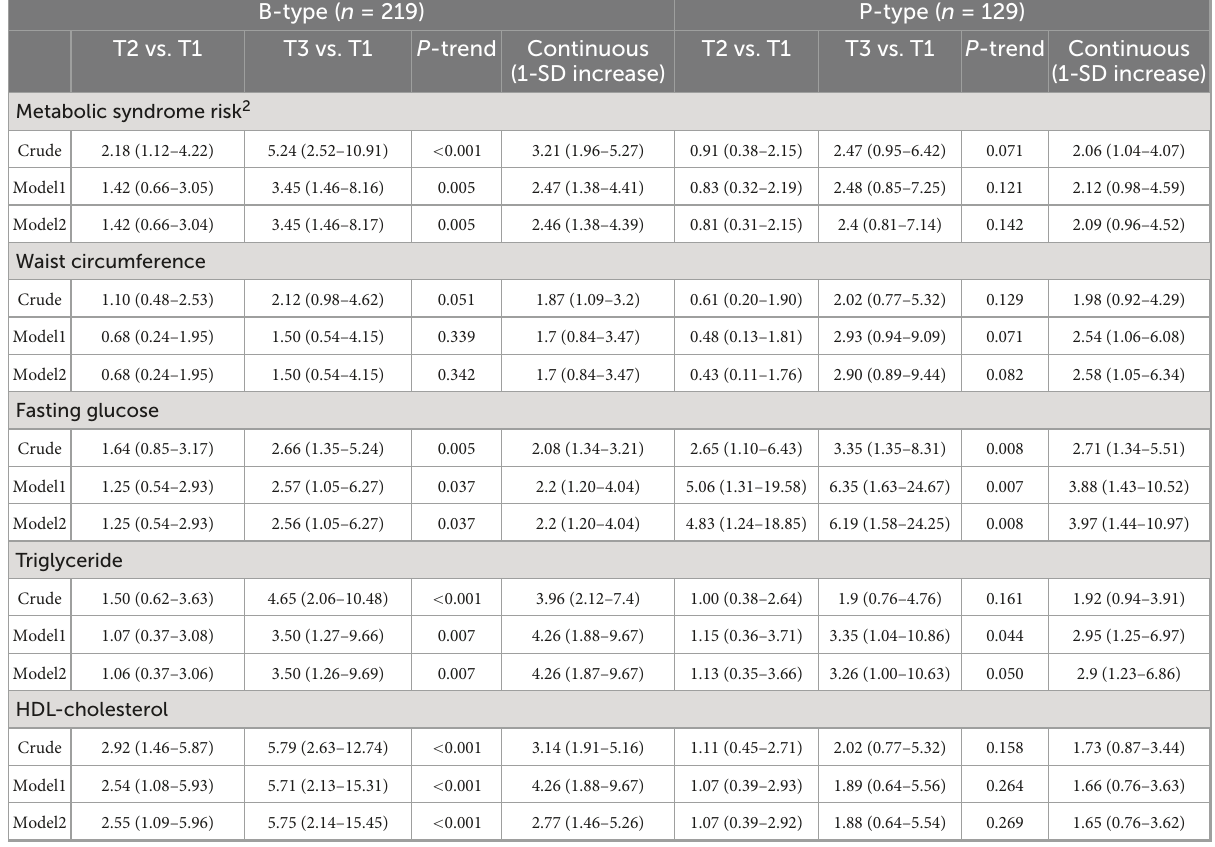
TABLE 5 Association between dietary pattern scores and risk of metabolic unhealthy status by enterotypes 1